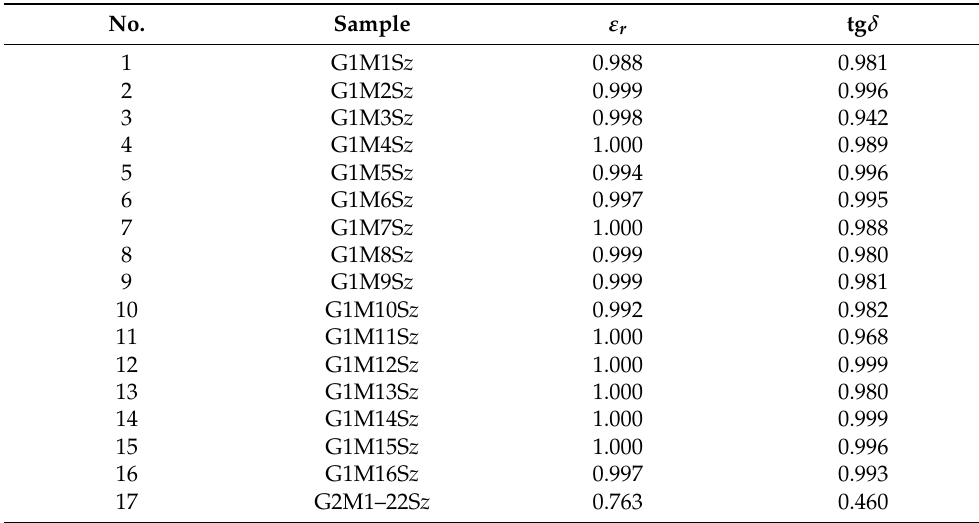
Table 7. Average value of Pearson’s coefficient from measurements of ε r i tg δ in G1 and G2 groups of